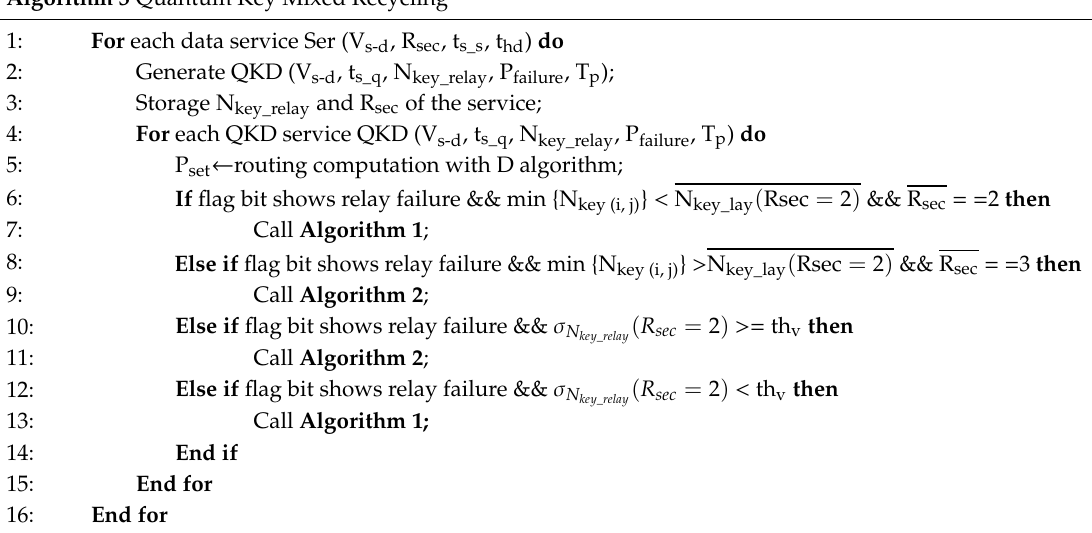
Algorithm 3 Quantum Key Mixed